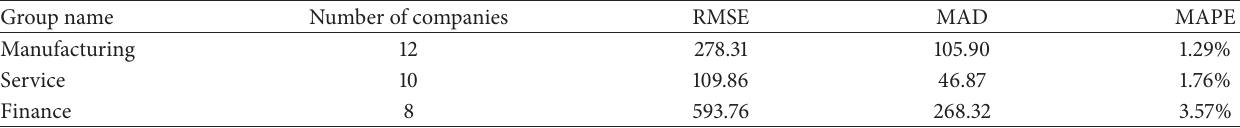
Table 5: The forecasting results of each group by using the ICA-GHSOM-SVR